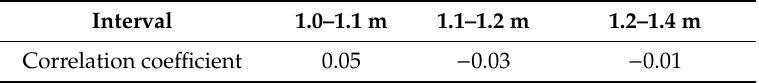
Table 3. Correlation coefficient between confidence and absolute error.